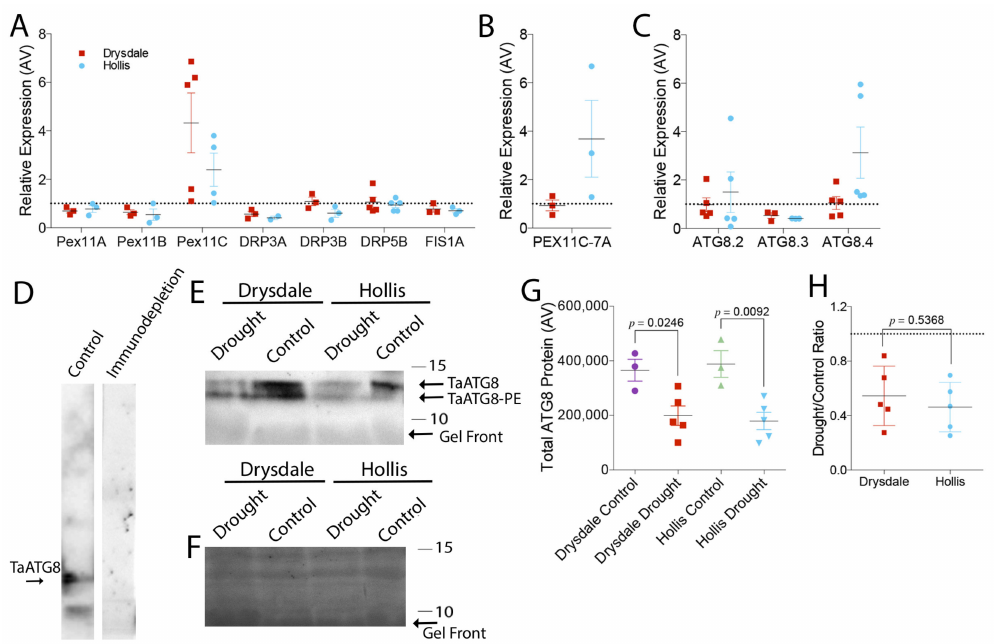
Figure 5. Drought response of peroxisome biogenesis and autophagy markers. ( A – C ) Transcription level of peroxisome fission genes ( A ), peroxisome fission gene PEX11-C homoeologs from chromo- some 7A ( B ) and autophagy flux marker ATG ( C ). qRT-PCR transcription levels were normalized to housekeeping gene RNase L inhibitor-like protein. Values above the dashed line indicate up- regulation; values below the line indicate down-regulation. ( D ) Western blotting with ATG8 antibody or following immunodepletion of the antibody with the ATG8 protein. Pre-incubation of the antibody with the antigen abrogates recognition of ATG8 in leaf total protein extract. ( E ) Western blotting with anti-ATG8 of total protein extracts from leaves of control and drought-stressed Drysdale and Hollis plants. Bars and numbers indicate the position and corresponding size of molecular weight markers. ( F ) Colloidal Silver staining of the corresponding Western blotting membrane showing total protein. Bars and numbers indicate the position and corresponding size of molecular weight markers. ( G ) Quantification of ATG8 protein abundance on the Western blotting membranes. p -values represent Student t -test results of three technical replicates of extracts from three biological replicates (individual plants). ( H ) The ratio of ATG8 protein in extracts from drought-stressed leaves to that in control leaves. p -values represent Student t -test results of three technical replicates of extracts from three biological replicates (individual